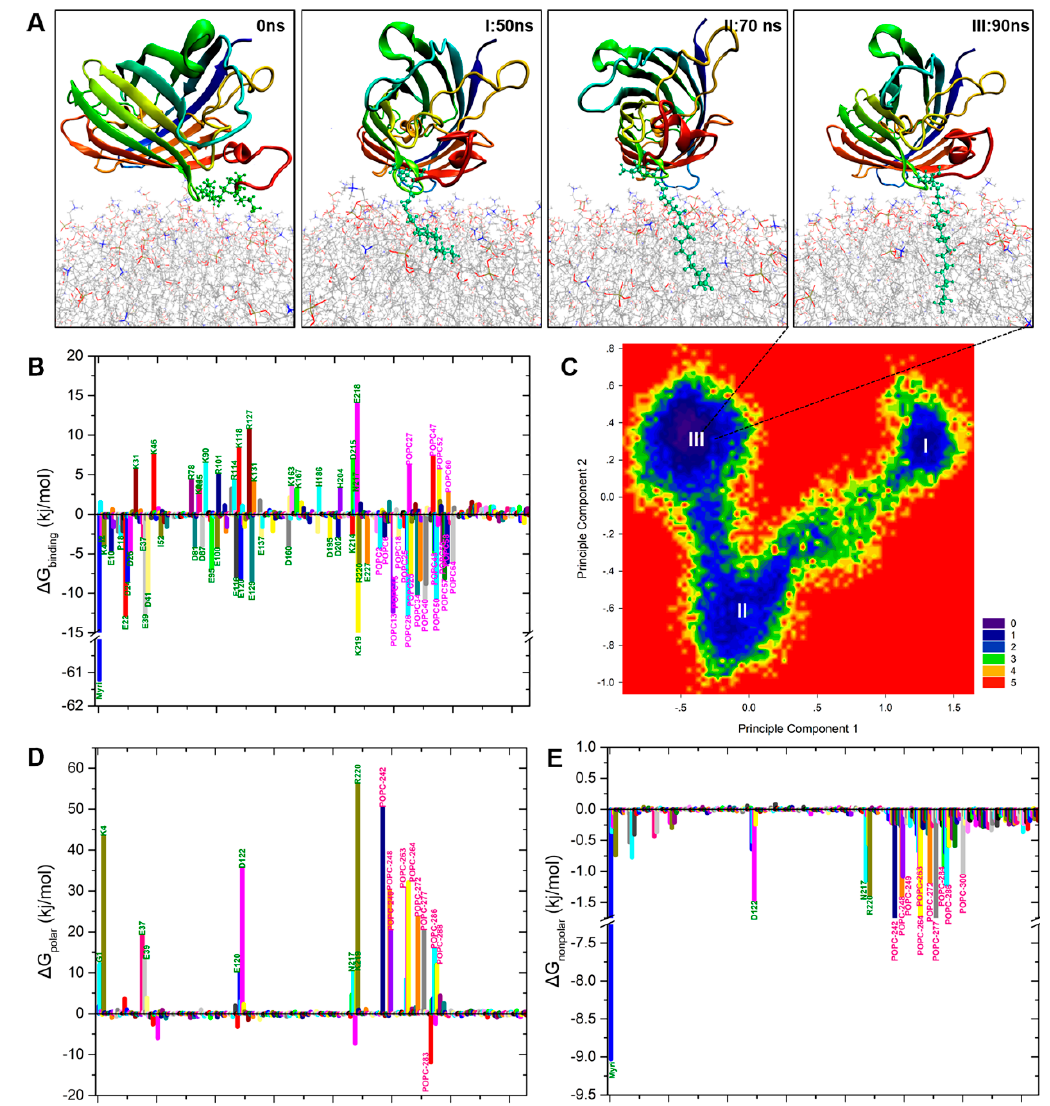
Figure 4. Atomic MD simulations reveal how the myristoyl group anchors GFP to a POPC membrane. ( A ) Snapshots showing the process of myristoyl group insertion into the lipid bilayer. The myristoyl moiety is highlighted in green and displayed in Corey-Pauling-Koltun (CPK) mode. ( B ) Binding free energy contributions of per-residue (olive green) and each POPC lipid (purple) to the formation of the protein-lipid bilayer complex. Error bars were not included since the standard errors were always considered in GROMACS algorithms. ( C ) Contour plot of the relative free energy landscape (FEL) determined from principal component analysis (PCA) using the first and second principal components for the myristoylated GFP-POPC system. The energy scale is given in kJ/mol, with red indicating the high free energy regions and blue the low free energy regions, corresponding to unfavorable and favorable conformations, respectively. Representative structures of the three highly-populated regions, I (50 ns), II (70 ns), and III (90 ns), with the energy minimum are also shown in ( A ). ( D ) Polar binding energy contribution of each residue in the myri-GFP-POPC system. ( E ) Nonpolar binding energy contribution of each residue in the myri-GFP-POPC system. The residues with the most favorable (< − 10 kJ/mol) contributions and unfavorable (>10 kJ/mol) are labeled.